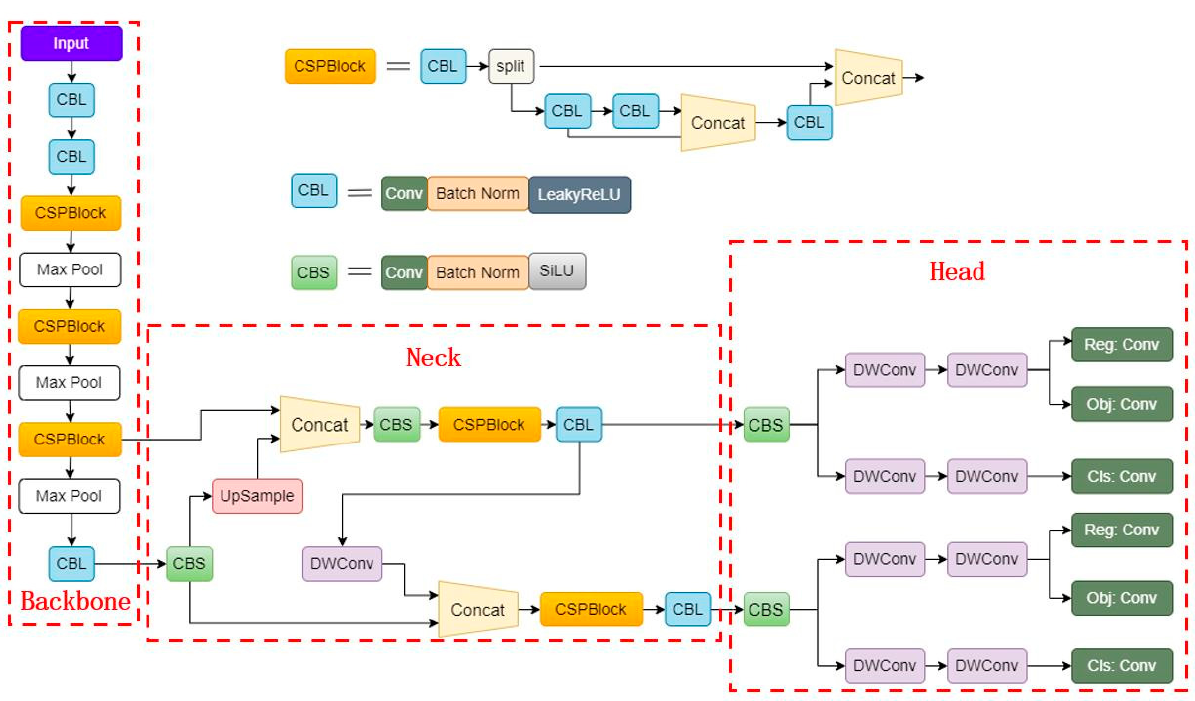
Figure 5. Improved YOLOX-Nano model structure.